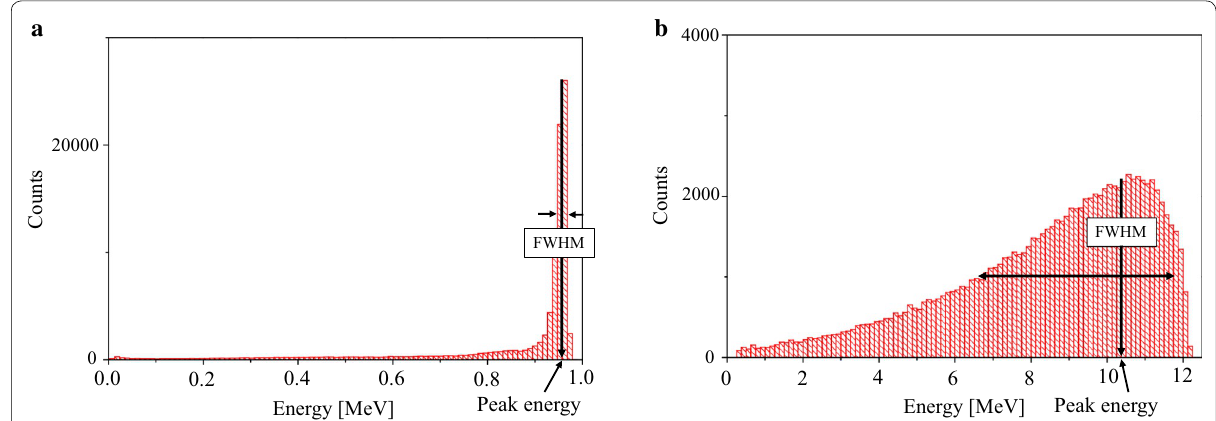
Fig. 3 Examples of the deposited energy spectra obtained by the GEANT4 simulation: a a deposited energy spectrum of the SSD region in the case of 1 MeV electron incident and b a deposited energy spectrum of the GSO scintillator region in the case of 14 MeV electron